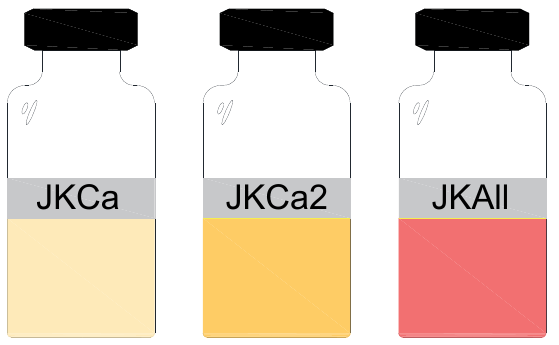
Figure 3. Samples of doped jarosite-type compounds obtained after synthesis.